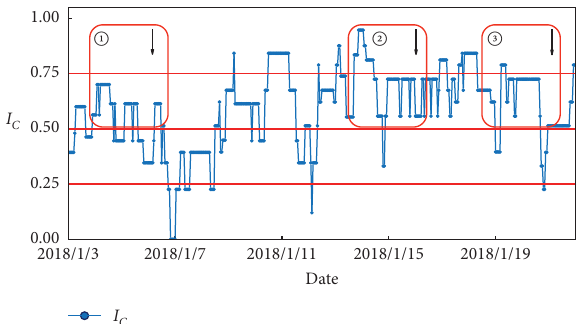
Figure 13: Integrated early warning index I C of rock burst risk in January 2018 ① 2018/1/6 04 :30: 48, 1.9 E +05J; 2018/1/6 04:30: 31, 9.8 E +05J; ② 2018/1/16 01:25: 45, 4.50 E +05J; ③ 2018/1/21 04: 07:24, 6.6 E